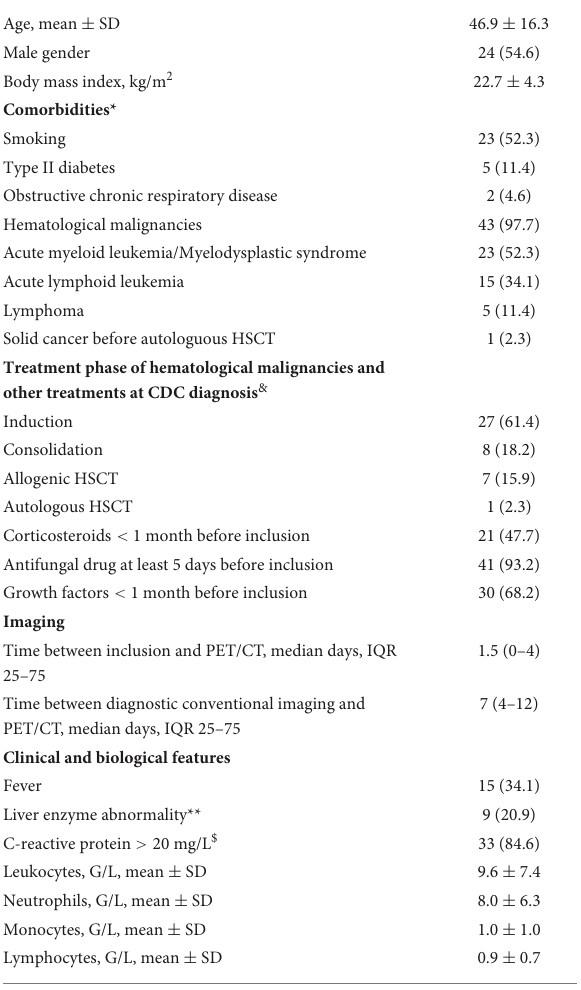
TABLE 2 Characteristics of 44 patients with chronic disseminated candidiasis (CDC) having a positron-emission tomography computed tomography (PET/CT) at